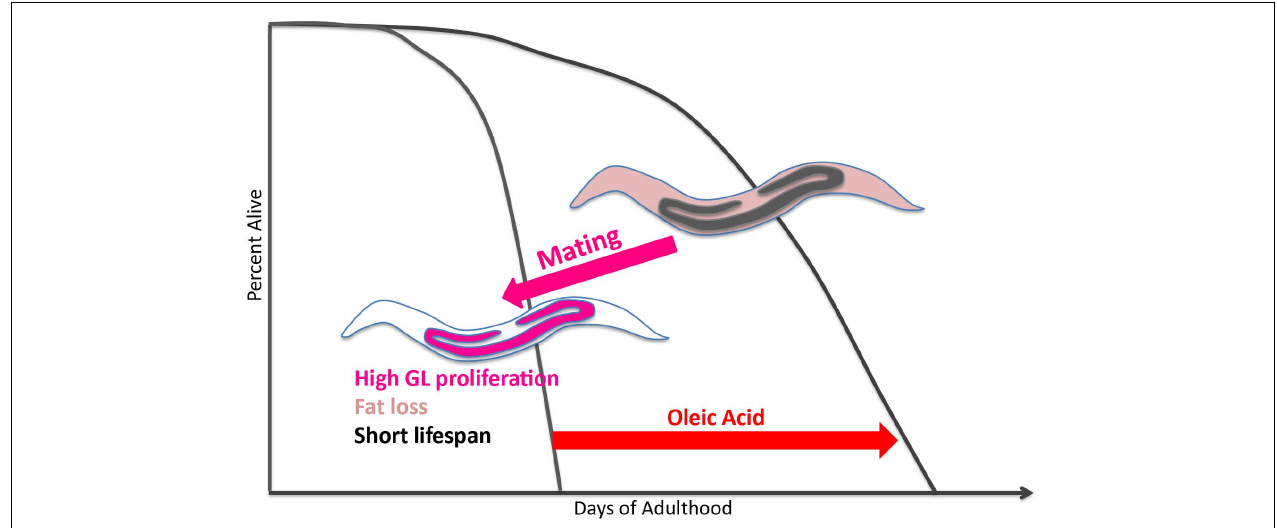
FIGURE 5 | Model of oleic acid-mediated lifespan restoration in mated worms. Mating leads to germline hyperactivity, fat loss, and shortened lifespan in Caenorhabditis mothers. Oleic acid addition (whether endogenously or exogenously) is able to restore the lifespan decrease caused by